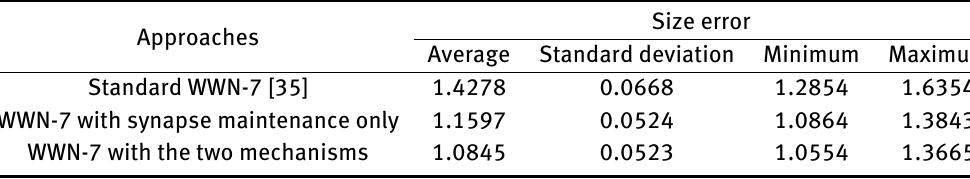
Table 8: Comparison of error on size between our work and the standard WWN-7 [35] Approaches